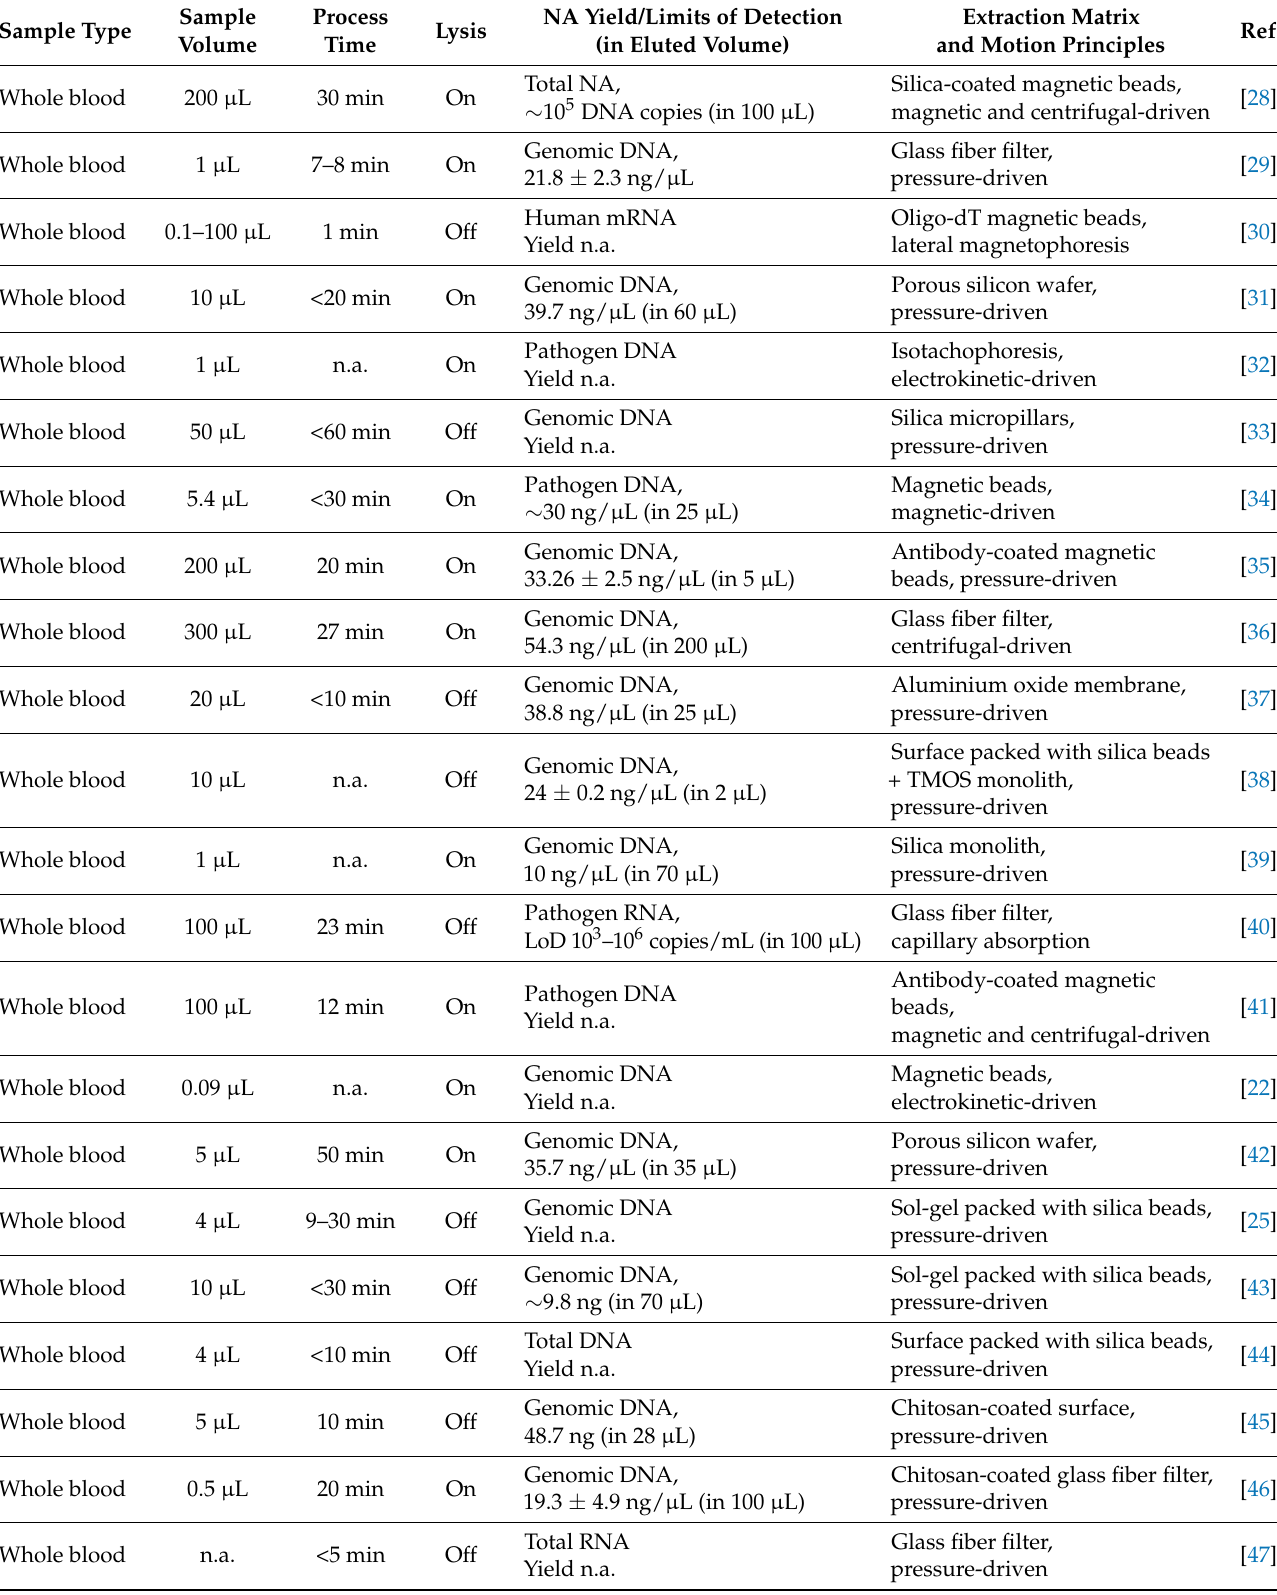
Table 1. Summary of the performances for considered LOCs. Type and volume of starting biological sample, on- or off-chip lysis, NA extraction yield, principles, and total time (including pre-processing, when